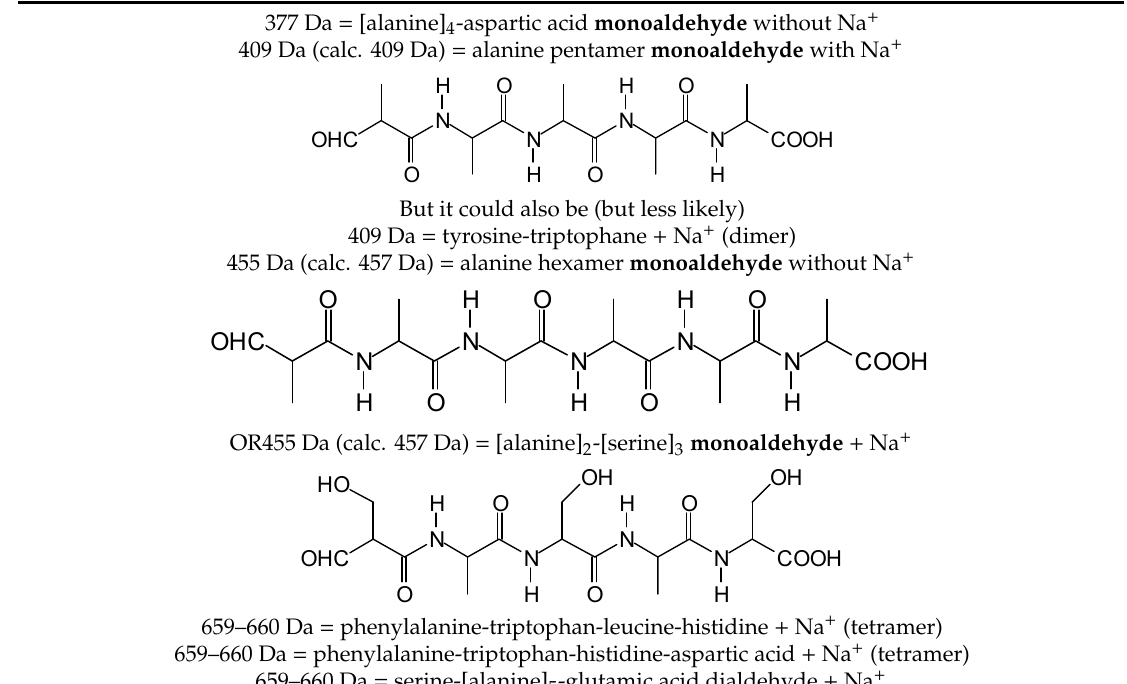
Table 2. The proposed oligomer species for the MALDI ToF spectra peaks in Figure 2a,b,c and Figure 3a,b for the reaction at 120 °C for 1 hour of sodium periodate with the soy protein isolate.